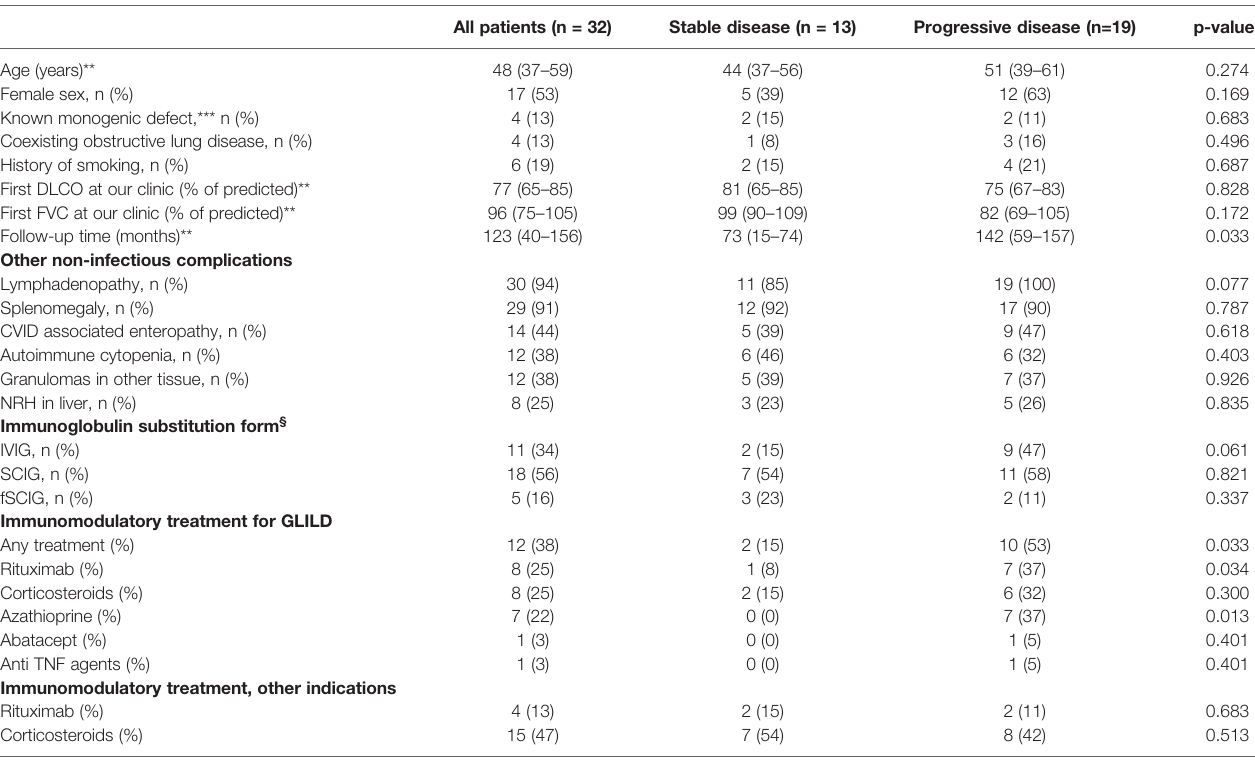
TABLE 1 | Patient characteristics. All patients (n = 32) Stable disease (n = 13) Progressive disease